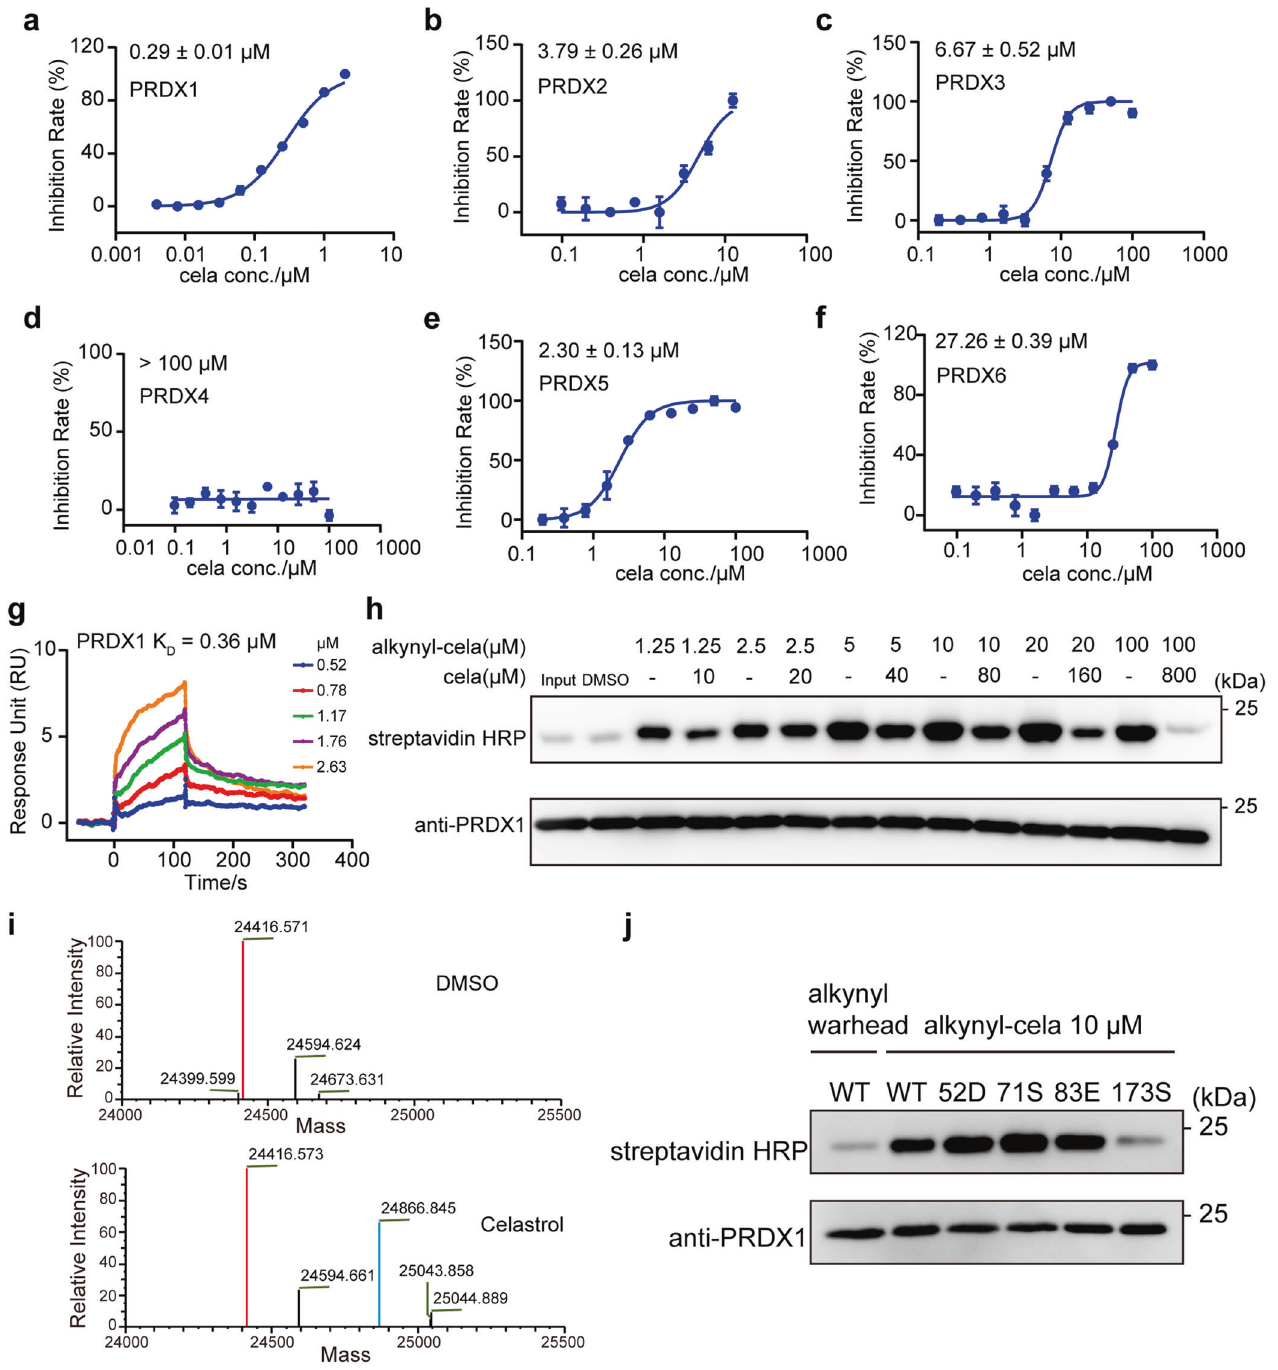
and carboxyl groups of Celastrol and the surrounding residues. For one Celastrol molecule, direct and water-bridged hydrogen bonds were observed with the Trp-87, Asn-89, Gln-94 residues of adjacent PRDX1 homodimer (Fig. 3b). While for another Celastrol molecule, direct and water-bridged hydrogen bonds were observed with the Arg-140, Thr-166, His-169 residues of another adjacent PRDX1 homodimer (Fig. 3c). In addition to these polar interactions, hydrophobic contacts were also observed between Celastrol and surrounding residues. For one Celastrol molecule, hydrophobic contacts were formed with the Phe-48 and Val-172 residues (Supplementary Fig. 3d), while for another Celastrol Signal Transduction and Targeted Therapy (2023)